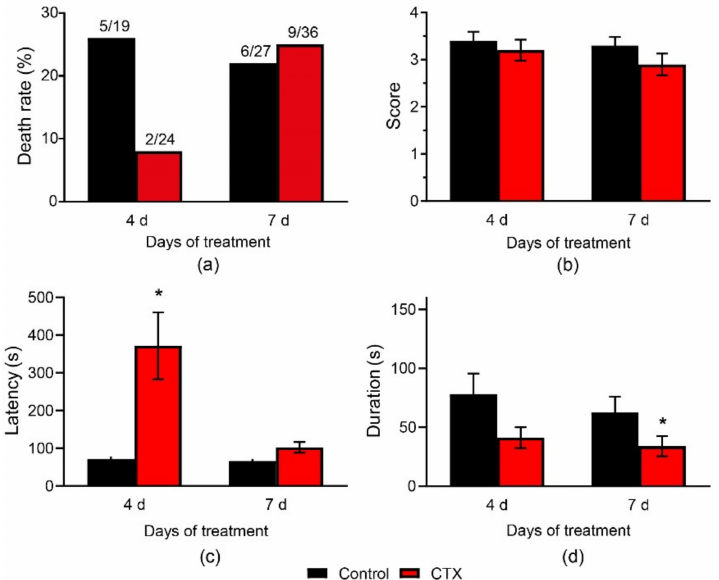
Figure 6. Pentylenetetrazol (PTZ)-convulsions after CTX administration. ( a ) Mortality, ( b ) mean maximal score, ( c ) latency, ( d ) total duration of convulsions. *—Significant di ff erence from the control group, Mann-Whitney U test, p <